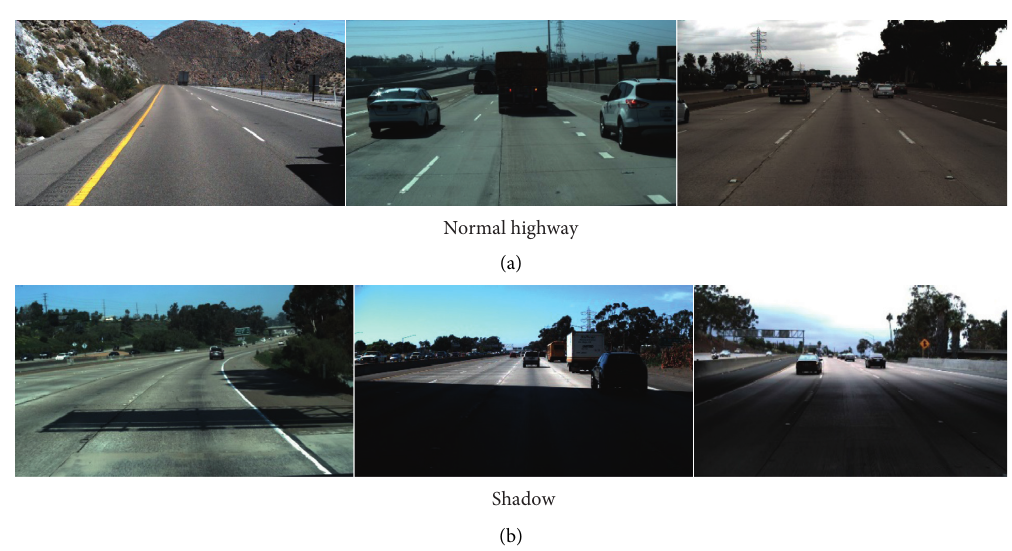
Figure 5: Some pictures in TuSimple dataset. (a) Normal highway. (b) Shadow.